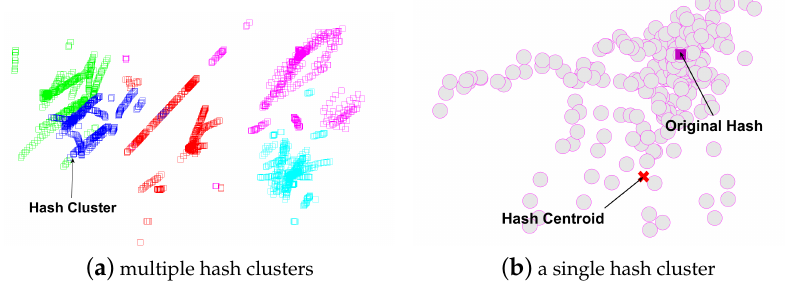
Figure 2. The examples of hash